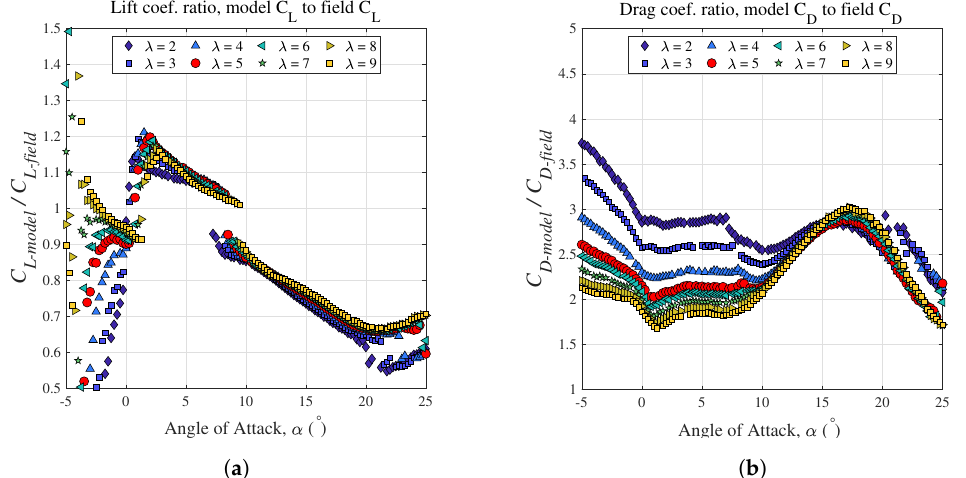
Figure 6. Ratio between simulated model and field scale ( a ) lift and ( b ) drag coefficients for a range of tip speed ratios. Red circles identify results near measured optimal performance for the RM1 model-scale